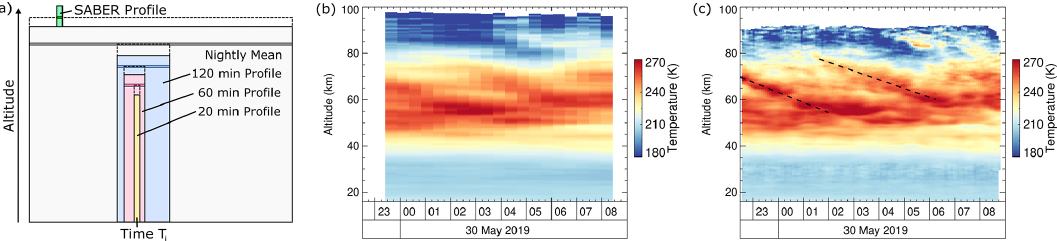
Figure 12. (a) Sketch of the pyramid of integration times that is built up by the retrieval when moving from longer to shorter integration periods. The horizontal bars with dark colors mark the altitude where the retrieval is seeded using the temperature profile from the preceding level. (b, c) Temperature profiles retrieved with (b) 120min integration time and (c) 20min integration time. Dashed lines highlight phase lines of gravity waves (see text for